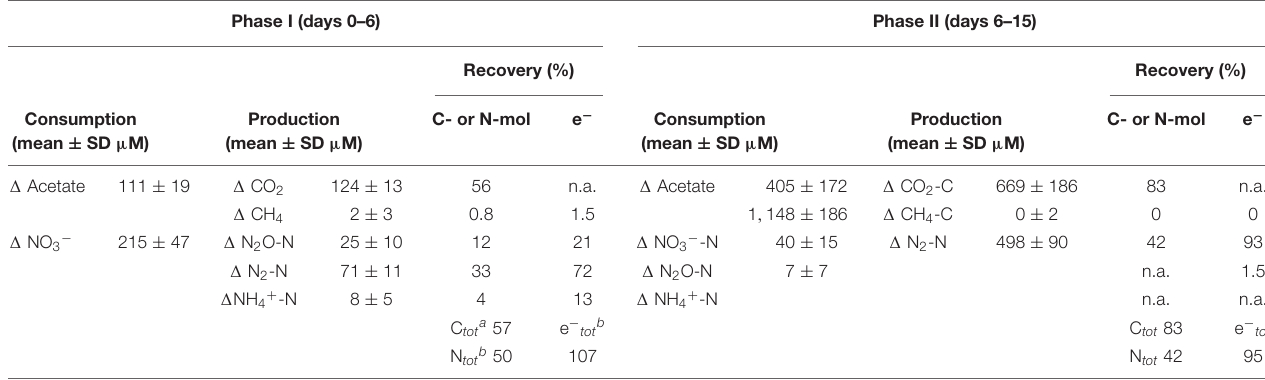
TABLE 2 | Mass- and electron balances during anoxic incubations of cryoturbated peat circle sediments in the presence of supplemental acetate and nitrate (see Figure 1